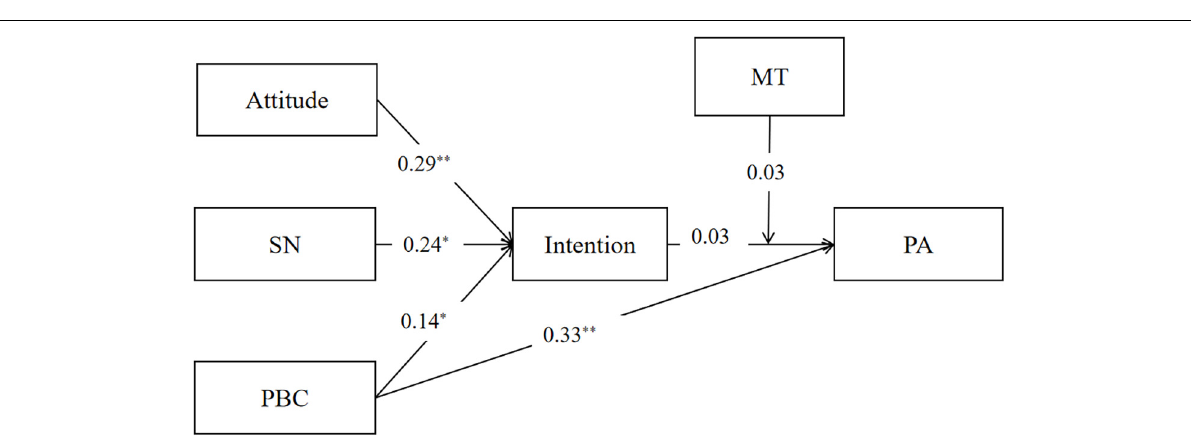
of MT ( t = 2.684, p < 0.01, 95% CI [33.366, 215.427]), but not significant at moderate levels ( t = 1.917, p = 0.056, 95%